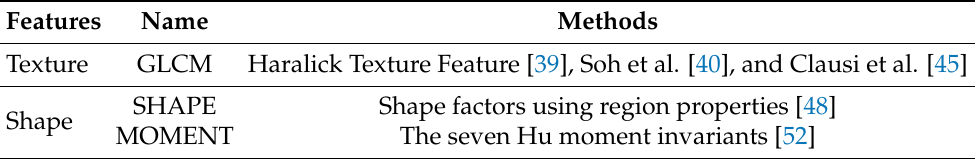
Table 1. Feature Extraction